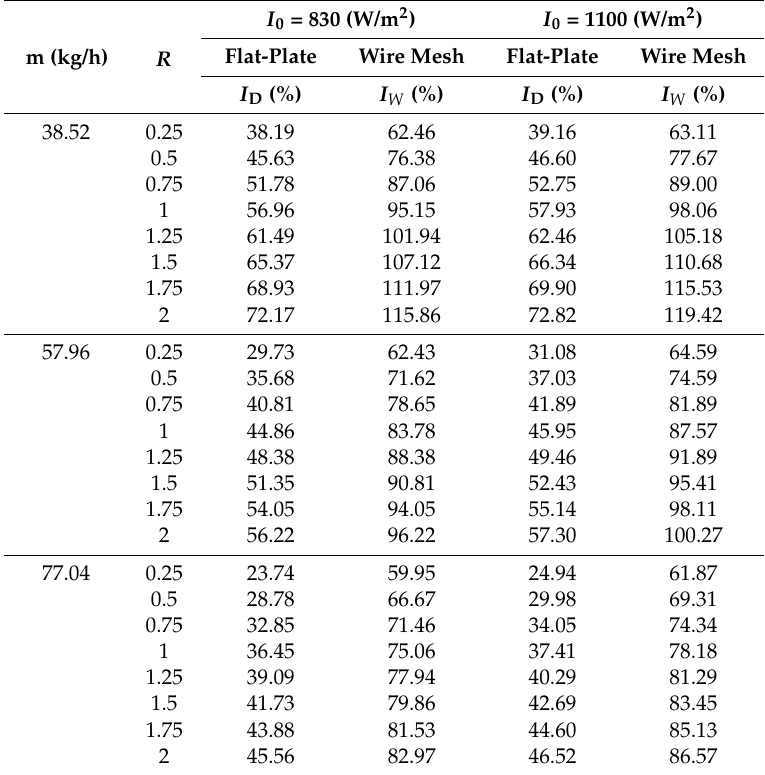
Table 2. Theoretical predictions of heat-transfer efficiency improvement of I D and I W